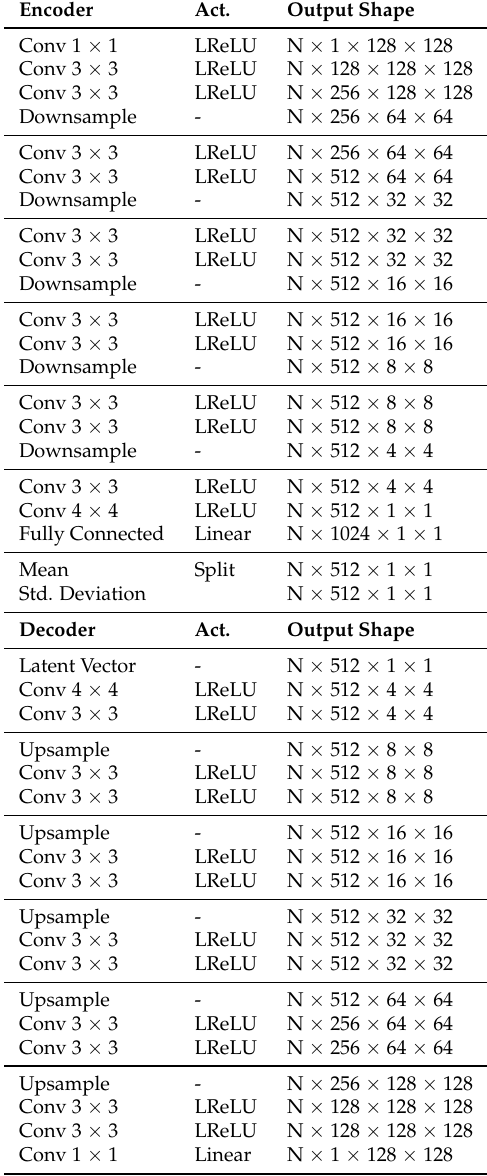
Table 1. A detailed overview of the encoder and decoder network